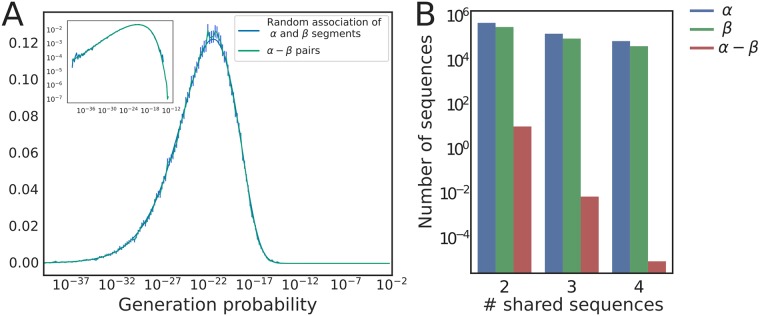
Generation probability of a full αβ TCR.(A) Distribution of the generation probabilities of αβ pairs, obtained by multiplying the generation probabilities of the α and β sequences. The graph shows the distribution for paired sequences (blue) and random associations of αβ pairs (green). The error bars represent three standard deviations, and the inset shows the same plot on a double logarithmic scale. (B) Number of CDR3 nucleotide sequences found in n among 10 individuals with a sample depth of N = 106 unique αβ TCR per individual. The probability of more than two people sharing the same TCR receptor is extremely small.